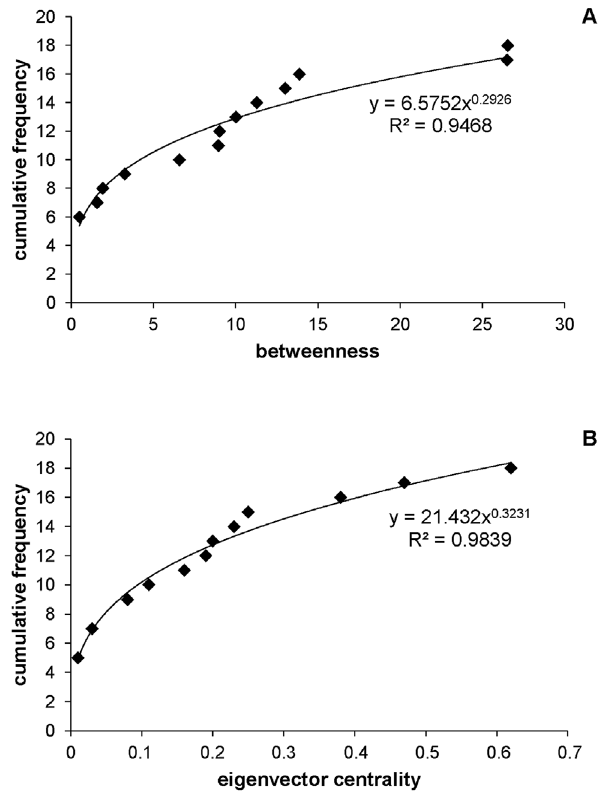
Figure 3. The cumulative distribution of centrality values for the contact network . (A) Betweenness values, and (B) eigenvector centrality values. Solid lines represent the power function fitted by the distributions.